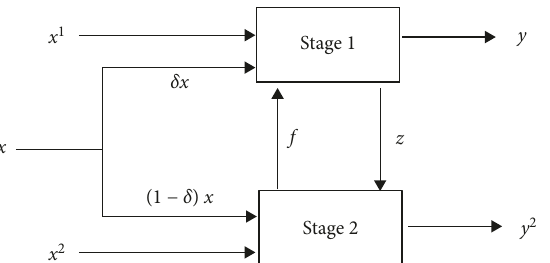
Figure 1: Two-stage structure including shared inputs and feedback.